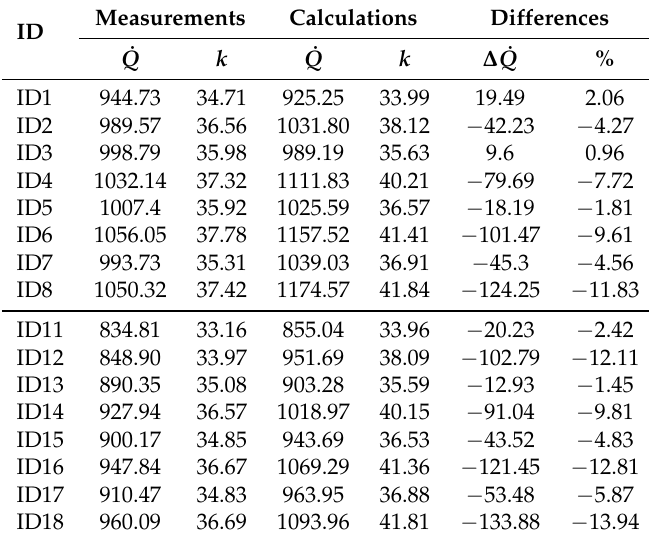
Table 9. Comparison of measurements and analytical calculations. ID